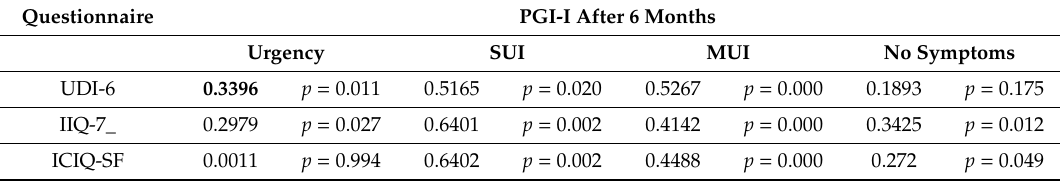
Table 5. The relationship between Patient Global Impression of Improvement (PGI-I) and the severity of functional disorders 6 months after surgery.